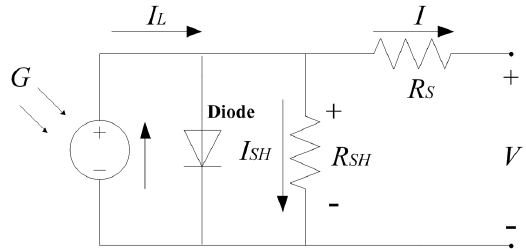
Figure 1. Equivalent circuit of PV cell.